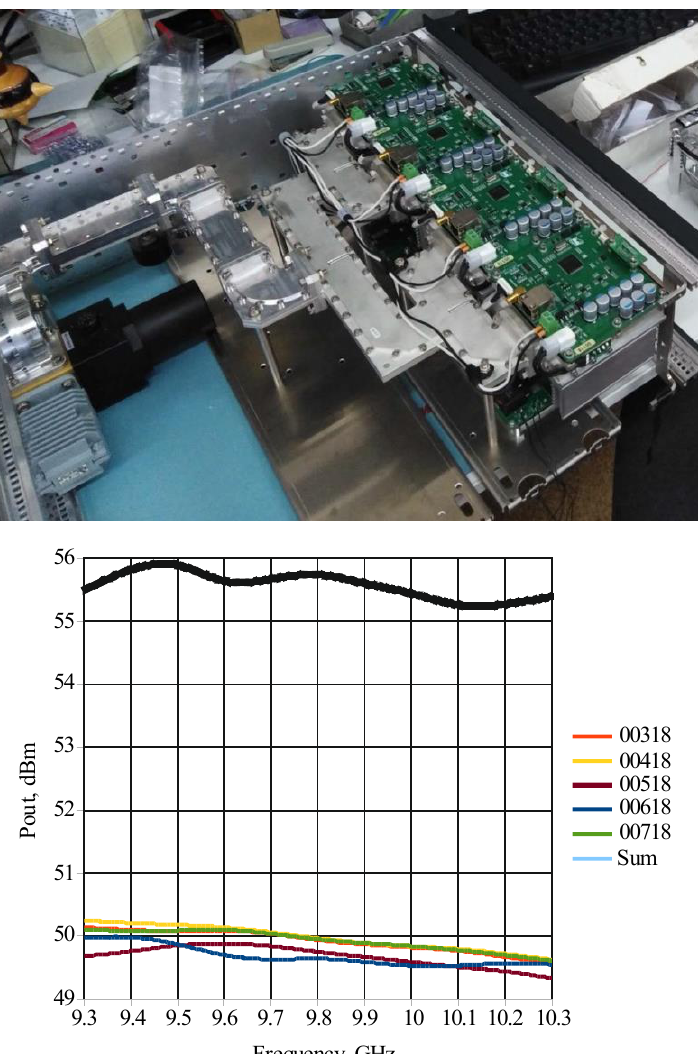
Fig. 2. X-band power amplifier with feeder elements mounted in X-band transiever (top) and frequency dependecies of output power of its four submodules and sum power and